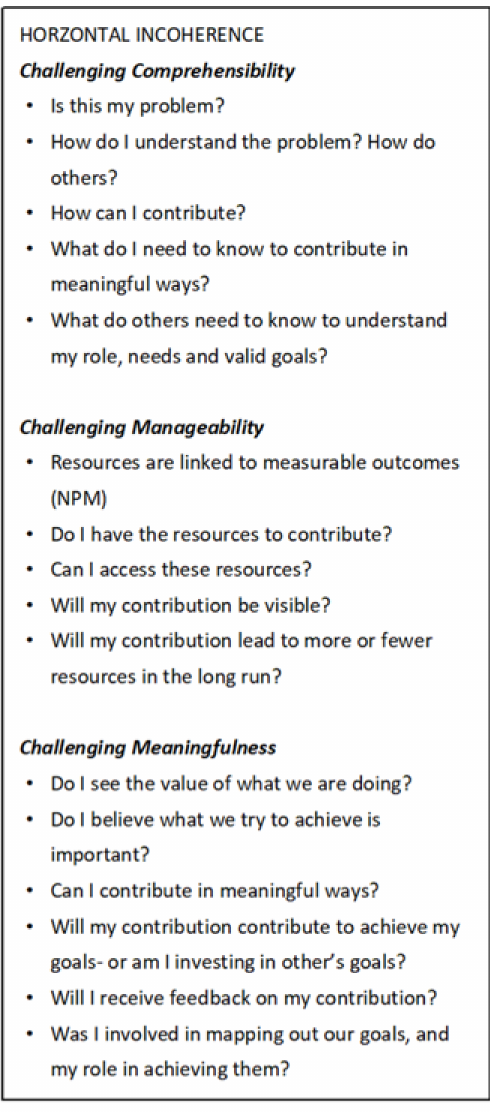
Figure 2. Horizontal